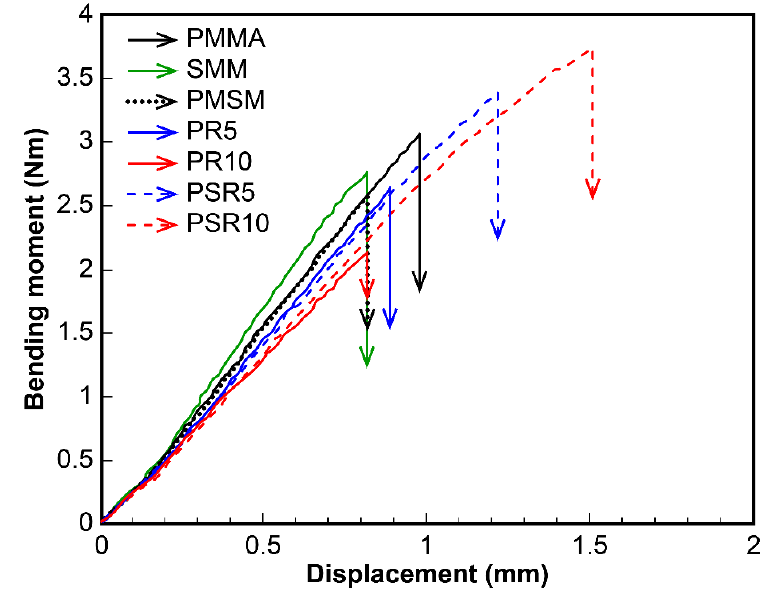
Figure 8. Toughness of U-notched PMMA, PMMA/PR blend, and PMMA/SMM/PR blend specimens measured in three-point bending tests.